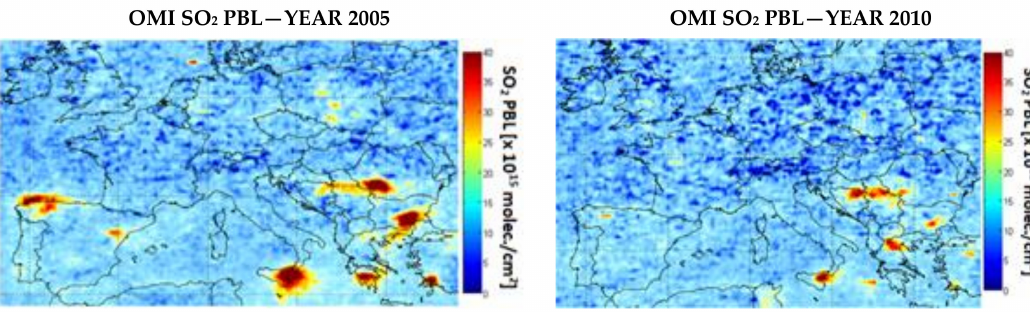
Figure 4. Annual tropospheric SO 2 PBL based on OMI observations for 2005 vs.